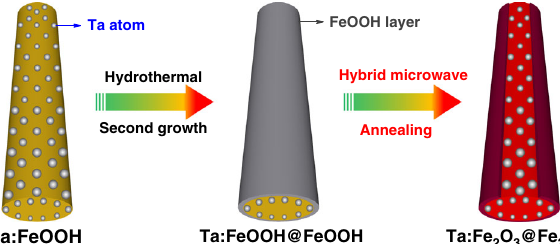
Fig. 1 Schematic synthesis procedure of Ta:Fe 2 O 3 @Fe 2 O 3 homojunction nanorods. Using hybrid microwave annealing, hematite homojunction nanorod is synthesized by hydrothermal regrowth of thin FeOOH layer on Ta:FeOOH